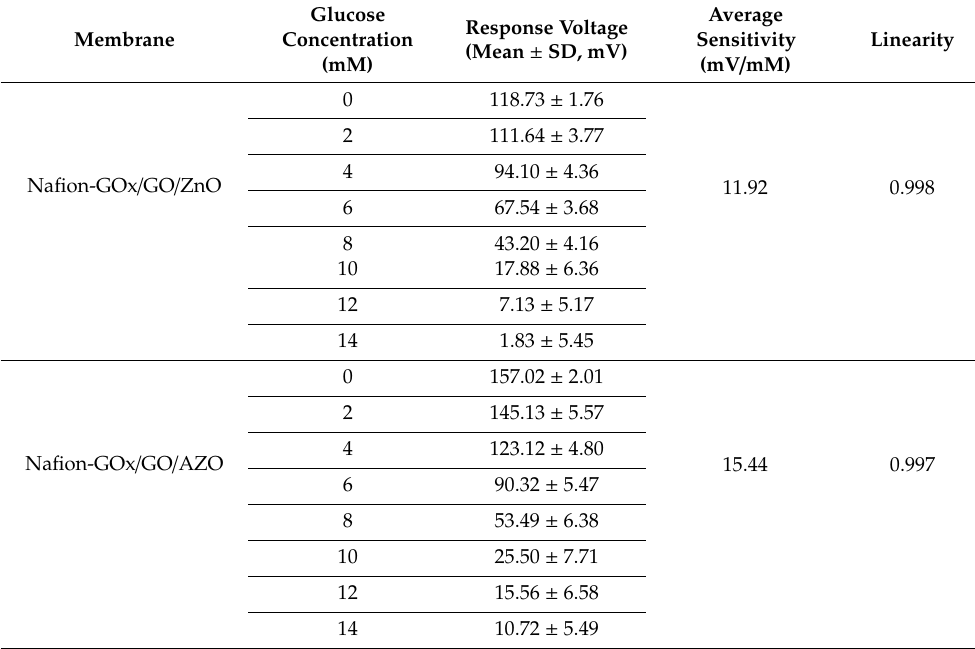
Figure 7. Response curves of the glucose biosensors over glucose concentrations ranging from 0 to 14 mM, for Nafion-GOx / GO / ZnO and Nafion-GOx / GO / AZO. AZO: aluminum-doped zinc oxide, GOx: glucose oxidase. Table 1. Sensing parameters of the potentiometric arrayed glucose biosensors over a glucose concentration ranging from 0 to 14 mM.